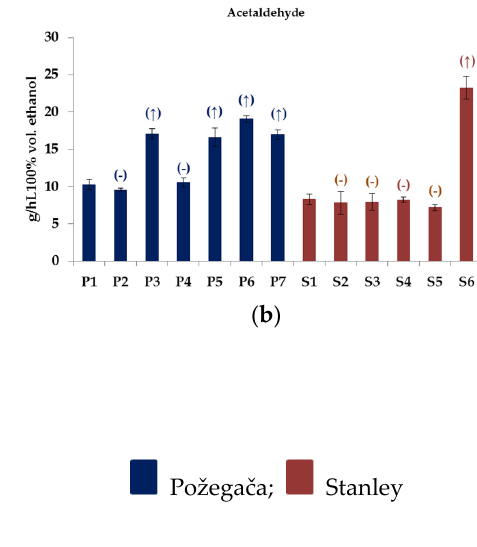
Figure 3. Content of fa tt y acids (g/hL 100% vol. ethanol) in plum spirits of Požega č a (P) and Stanley (S) varieties produced by traditional method (P1 and S1) and modi fi ed methods (P2–P7 and S2–S7): ( a ) TFA, ( b ) FA1, ( c ) FA2, and ( d ) FA3. (Codes are listed in Table S1 of Supplementary Materials.) For each plum variety, di ff erent marks indicate di ff erences in the means ( p < 0.05), according to Dunne tt test: ( ↑ ) Statistically signi fi cant higher values compared to values in traditionally produced plum spirit, ( ↓ ): Statistically of all parameters are shown as mean ± standard deviation.